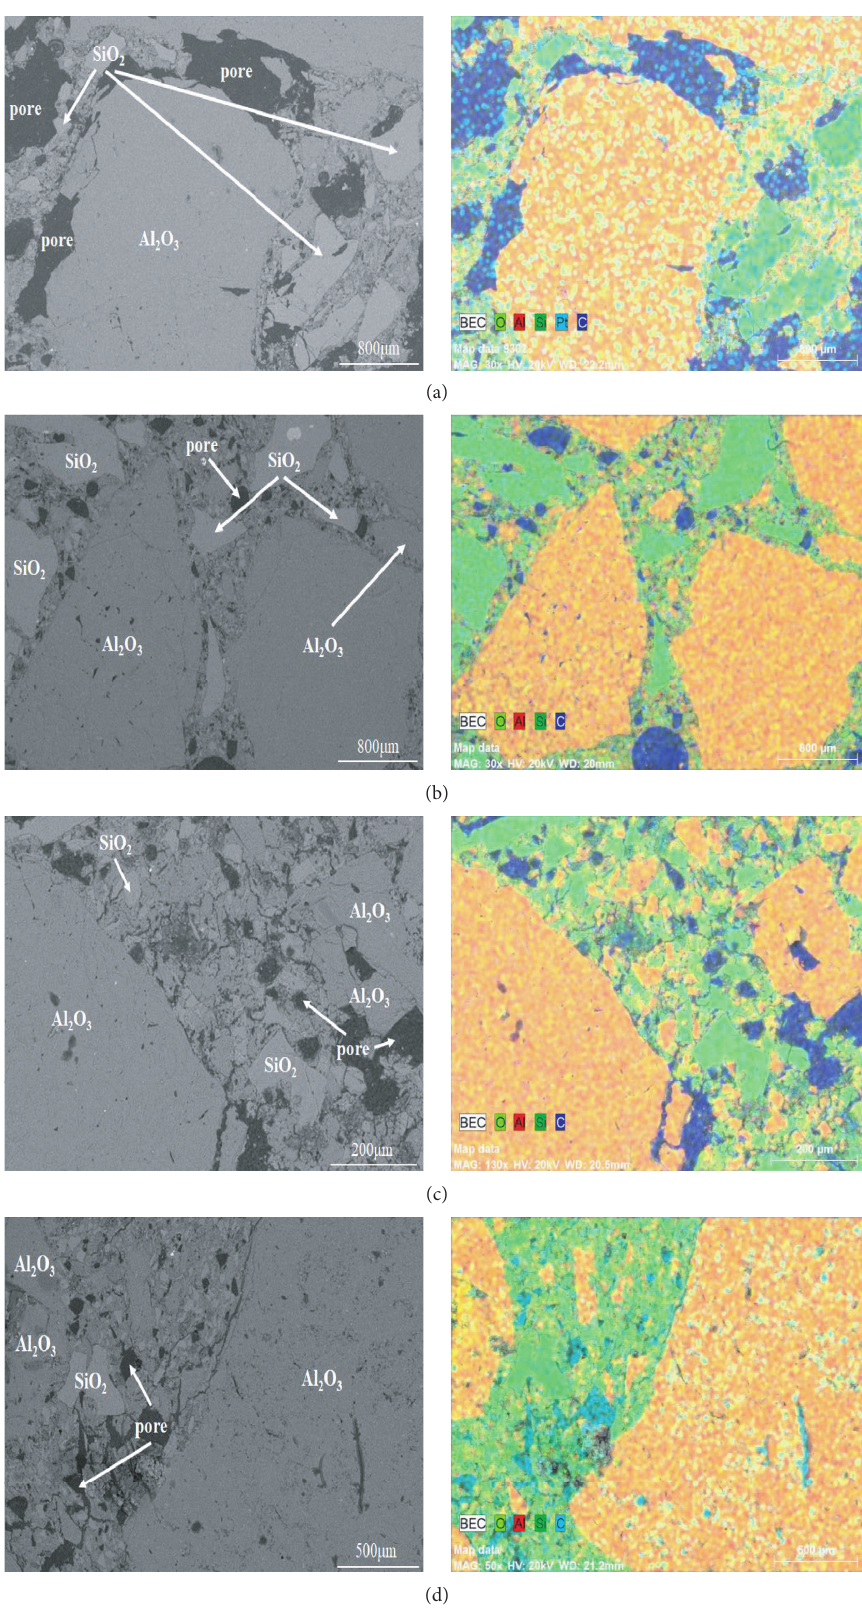
Figure 5: SEM images of samples with different submicron SiO